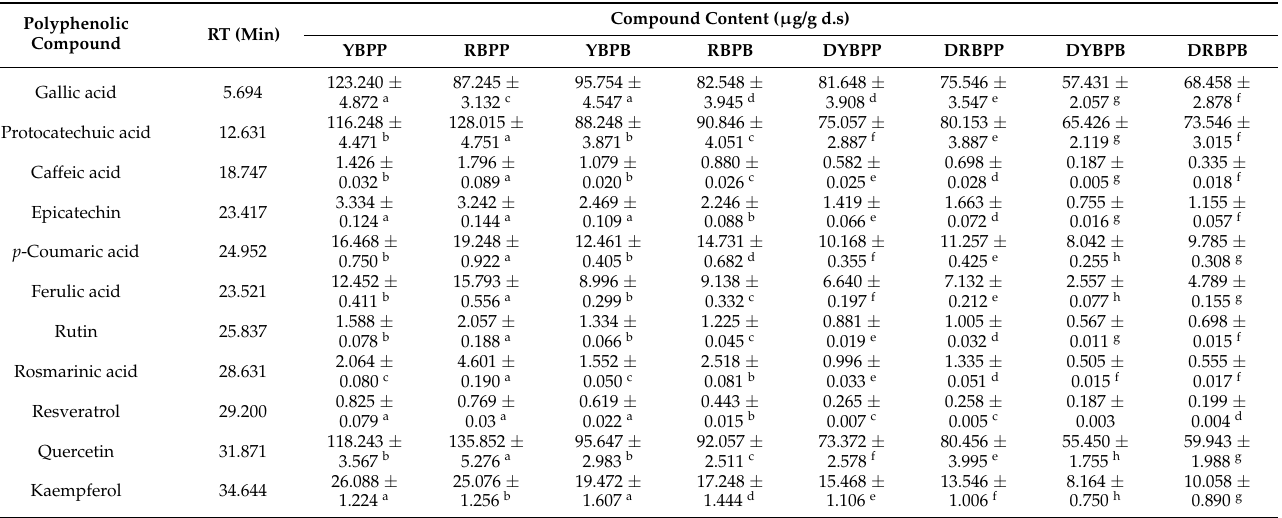
Table 2. Polyphenolic compounds content of red and yellow bell pepper pulp and processing by-products, fresh and after